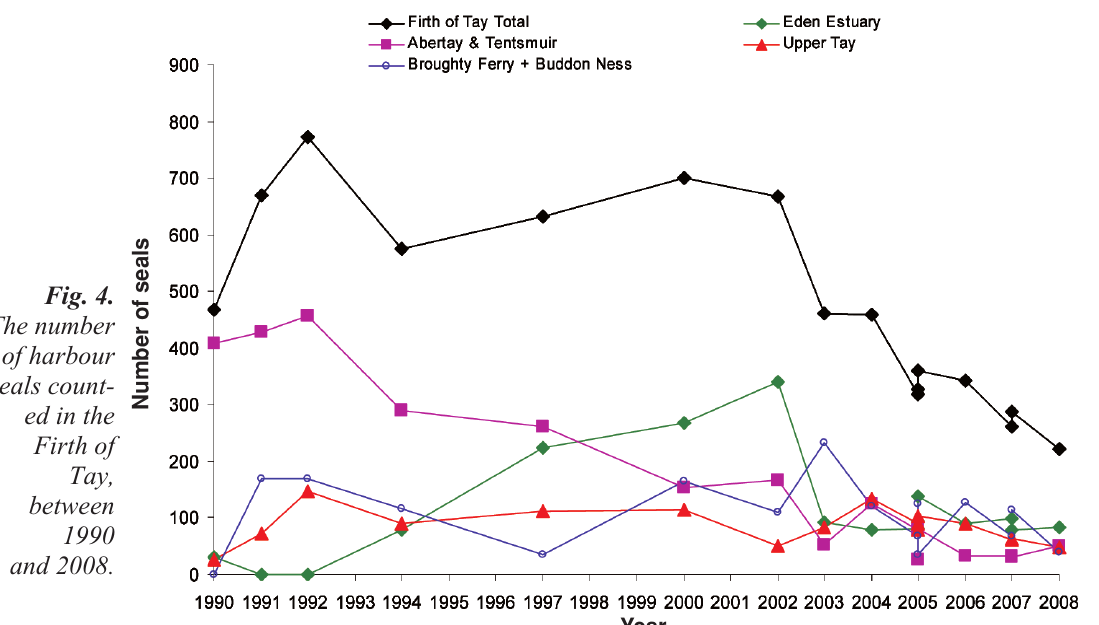
mately 50% higher than that in winter and the coefficients of variation are likely to be lower (details in Thompson et al. 2005).